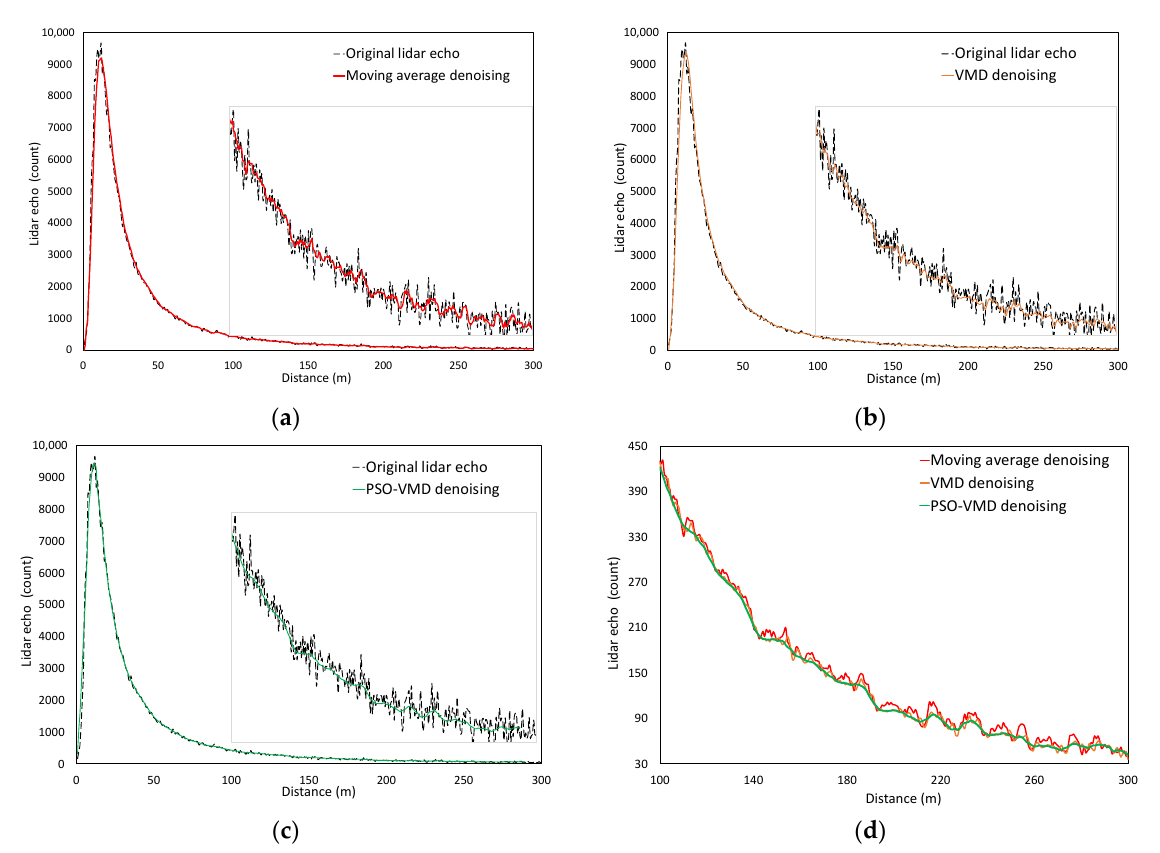
Figure 5. Denoising result of LED-lidar echo: ( a ) moving average; ( b ) VMD; ( c ) PSO-VMD; ( d ) comparison of ( a – c ).